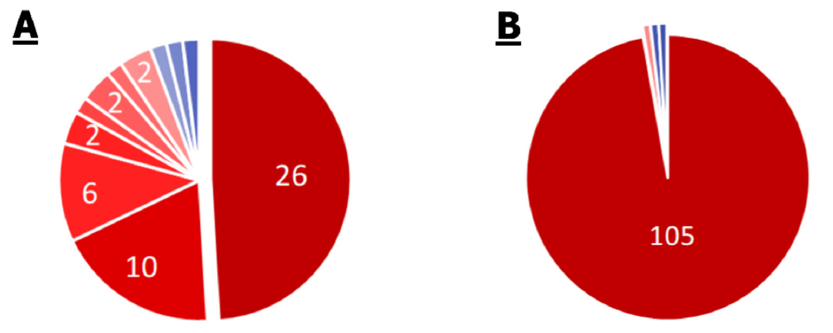
Figure 2. Pie chart of the proportion of annotations in the 53 genomes of S. aureus strains. Numbers depict annotations with equal frequency. Frequency—from 0.02 to 1—is presented in the color of slices on the scale from blue to red for distribution of modules ( A ) and pathways ( B ). Small slices without numbers correspond to the sole annotation with such frequency. Among 26 core modules (with frequency equal to 1), there are two modules of multidrug resistance, two modules of AMP resistance, and 22 different metabolic modules. Among 10 modules with frequency equal to 0.98, all modules are metabolic. Among six modules with frequency equal to 0.85, there are two of multidrug resistance and one of AMP resistance, the rest are metabolic. The beta-lactam resistance module is present in 45% of genomes, the methicillin resistance module in 24%, and multidrug resistance efflux pump QacA in 21%. The rest of modules are metabolic. Ninety-seven percent of pathways are present in every genome.